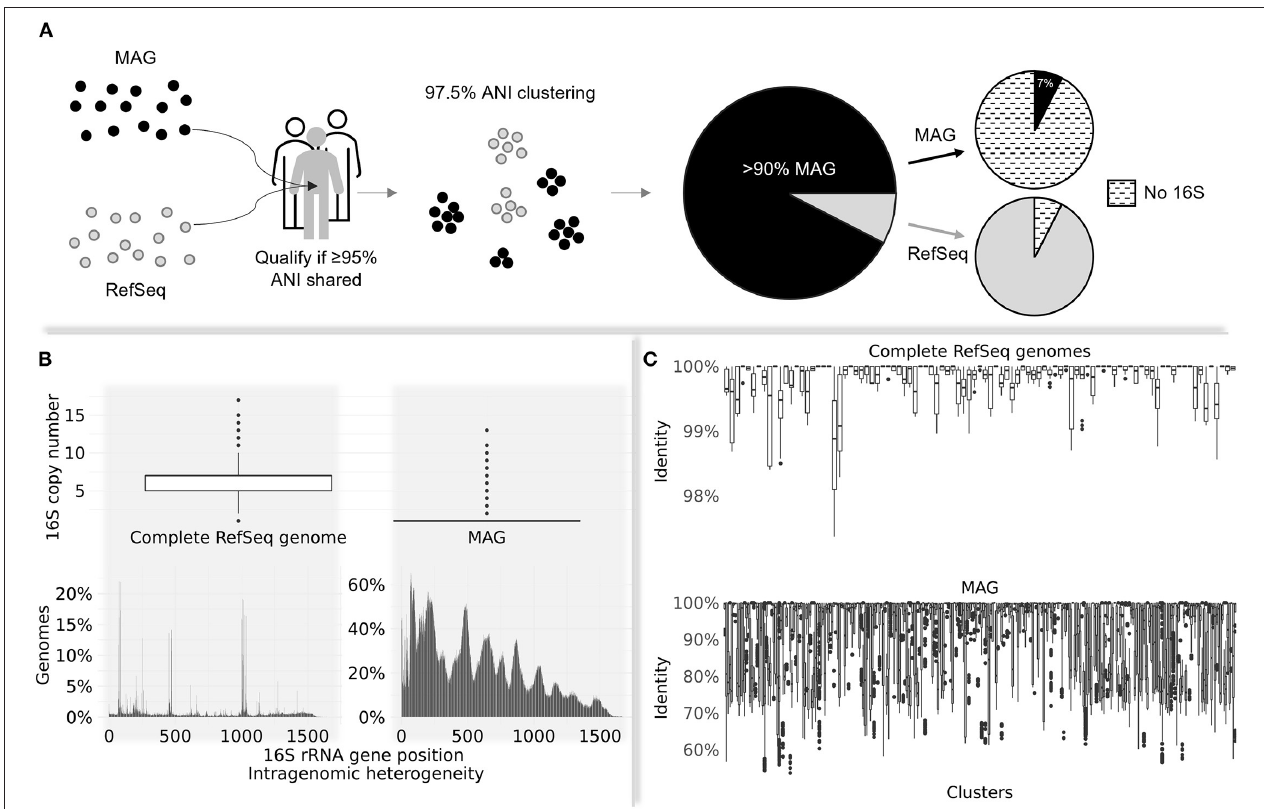
FIGURE 1 | (A) The process of filtering human gut-derived MAGs and RefSeq prokaryotic genomes against a pool of > 3,500 non-redundant healthy human gut metagenomes. Only genomes sharing ≥ 95% average nucleotide identity (ANI)—a conventional threshold marking species delineation (Jain et al., 2018)—were kept for further processing. The qualified genomes dereplicated at 97.5% ANI were mostly represented by MAGs ( > 90%). Only 7% of MAGs harbored detectable 16S rRNA gene sequences, while the opposite was observed in RefSeq genomes (7% lacked detectable 16S). (B) The distribution of 16S copy numbers on complete RefSeq genomes vs. MAGs (upper panel); the intragenomic 16S rRNA gene heterogeneity on genomes with multiple 16S copies for the same groups (bottom panel). MAGs are associated with increased intragenomic variability across all positions compared to RefSeq genomes. (C) The average nucleotide identity of 16S sequences belonging to the same 97.5% ANI cluster. Each boxplot refers to one cluster. The upper panel depicts clusters made of pure complete RefSeq genomes, while the bottom panel shows the distribution of shared identities on clusters entirely comprising MAGs. RefSeq-derived 16S sequences within same clusters show high identity (average of 99.8%); MAG clusters contain highly variable 16S sequences, with an average identity of